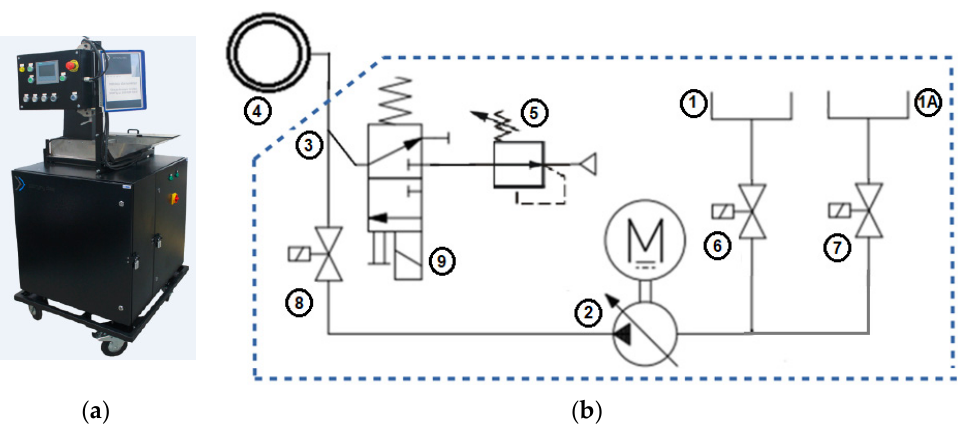
Figure 3. View: ( a ) the lubricating and cooling station, called “Shako”; ( b ) lubricant dosing system diagram, 1—lubricant tank, 1A—cleaning agent tank, 2—force pump, 3—tee, 4—head with nozzles, 5—pressure regulator, 6—cut-off valve of the liquid lubricant tank, 7—cut-off valve of the cleaning liquid tank, 8—cut-off, metering valve, 9—air valve of air exerting pressure on the liquid.